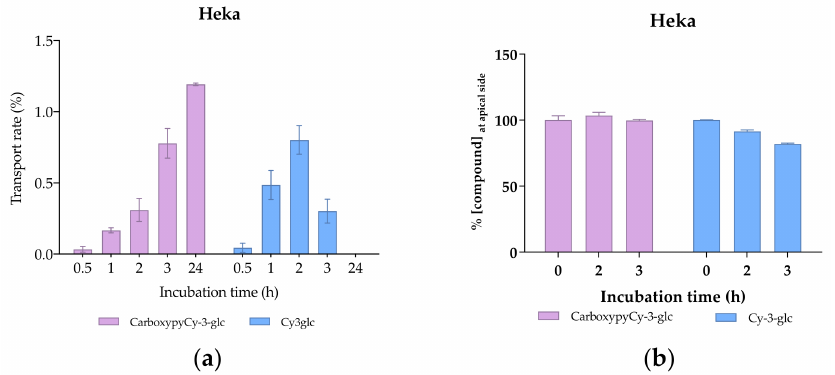
Figure 12. Transport efficiency of 200 µ M of Cy3glc and CarboxypyCy-3-glc through HeKa cells (apical → basolateral) monitored for 24 h at the ( a ) basolateral and ( b ) apical